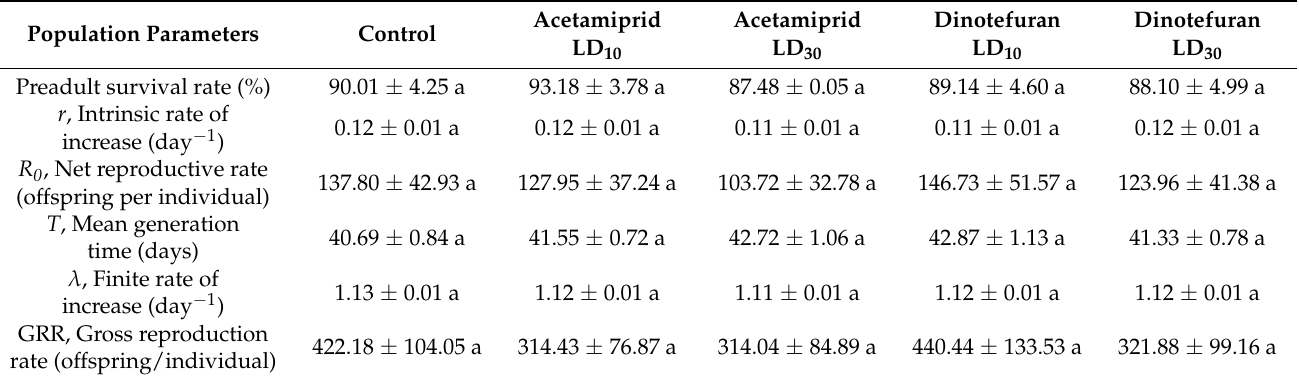
Table 3. Sublethal effects of acetamiprid and dinotefuran on the population parameters (mean ± SE) of C. pallens adults exposed to insecticide from the 2nd instar larval